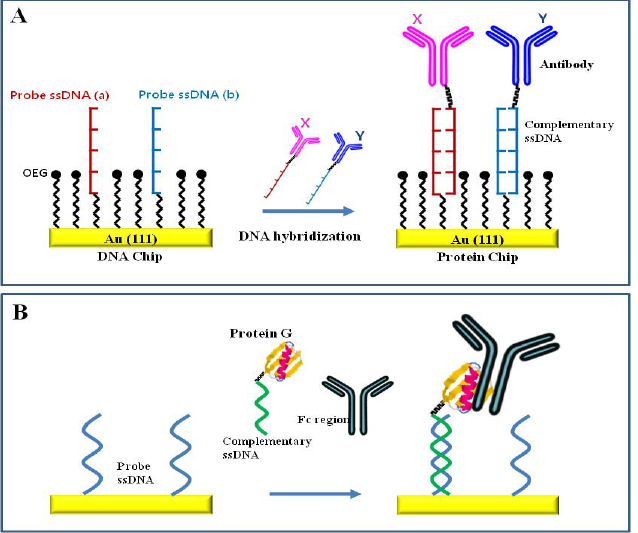
Figure 6. Schematic of (A) DNA-directed immobilization of DNA-protein conjugates using complementary hybridization of DNA. Reproduced with permission of ACS [72], and (B) DNA-directed antibody immobilization by the protein G-DNA conjugate. Reproduced with permission of ACS